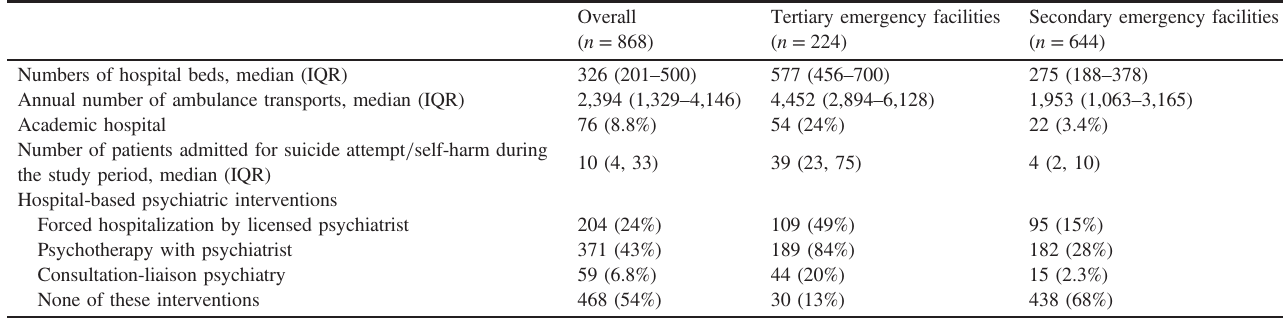
Table 4. Characteristics of hospitals that provided acute-care hospitalization for suicide attempt and self-harm Overall Tertiary emergency